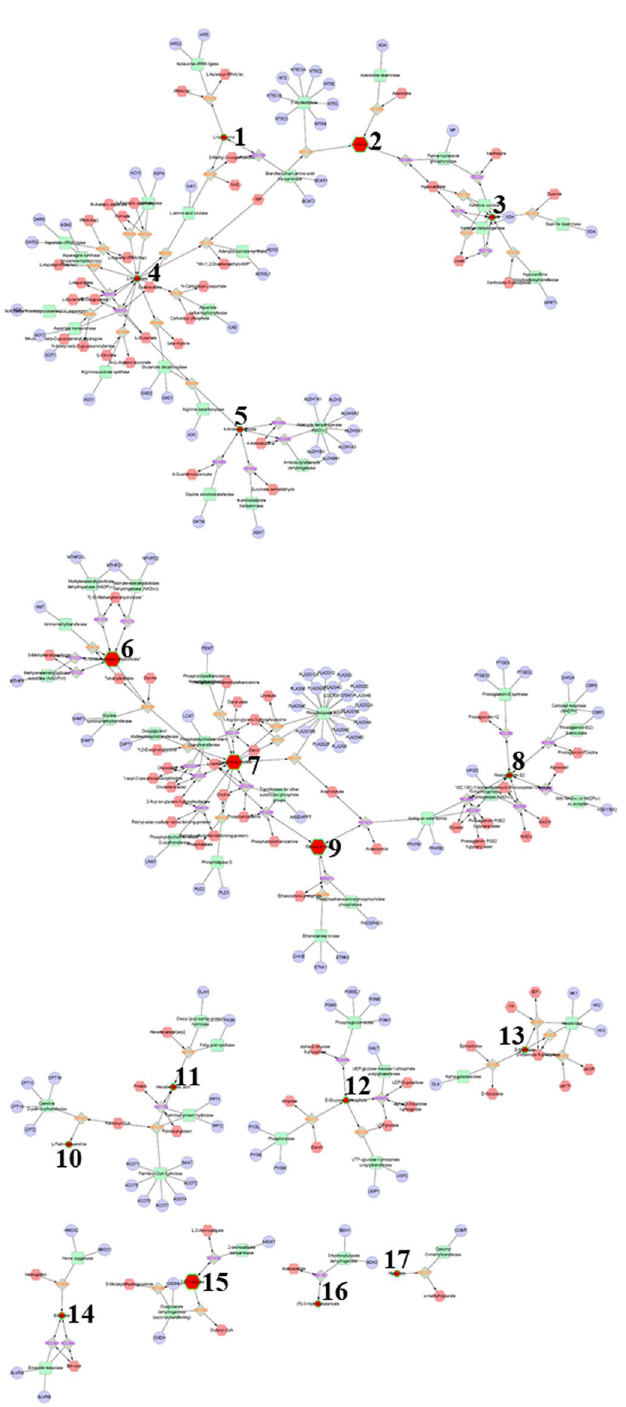
Figure 6. Networks of indicated differential metabolites. 1. L-Isoleucine. 2. Inosine. 3. Xanthine. 4. L-Aspartate. 5. 4-Aminobutanoate. 6. 5, 10-Methylenetrahydrofolate. 7. Phosphatidylcholine. 8. Prostaglandin E2. 9. Ethanolamine. 10. L-Palmitoylcarnitine. 11. Hexadecanoic acid. 12. D-Glucose-1-phosphate. 13. D-Mannose. 14. Biliverdin. 15. 2-Oxoadipate. 16. (R)-3-Hydroxybutanoate. 17.